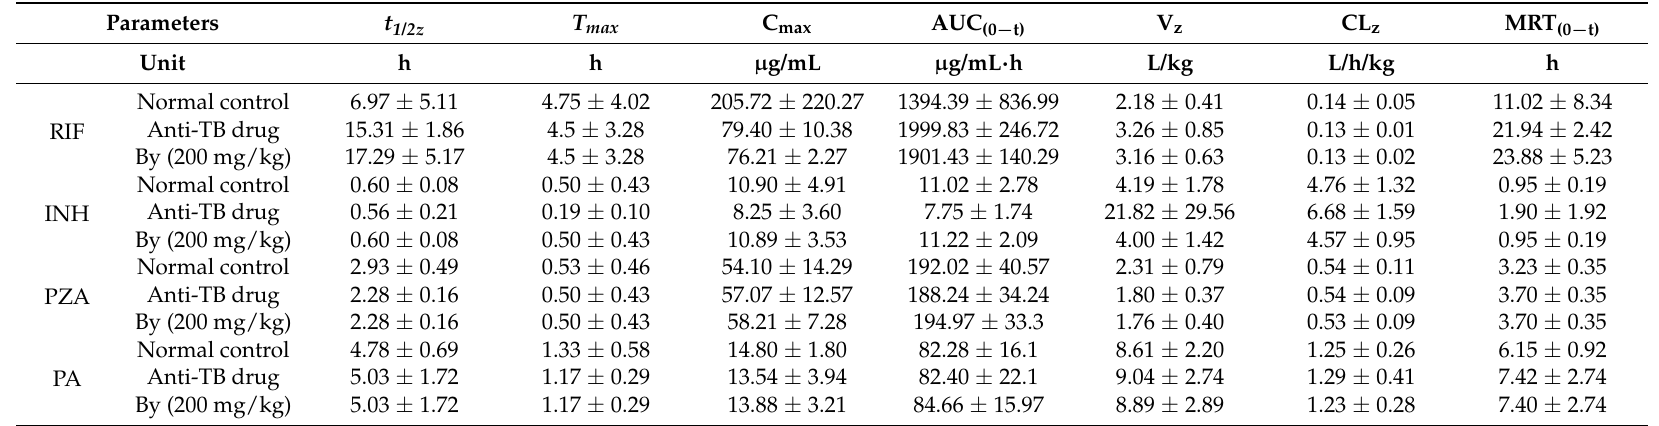
Table 3. Pharmacokinetic parameters of isoniazid (INH), rifampicin (RIF), pyrazinamide (PZA), and pyrazinoic acid (PA) in normal, anti-TB drug-intoxicated, and bicyclol (200 mg/kg)-treated rats for 30